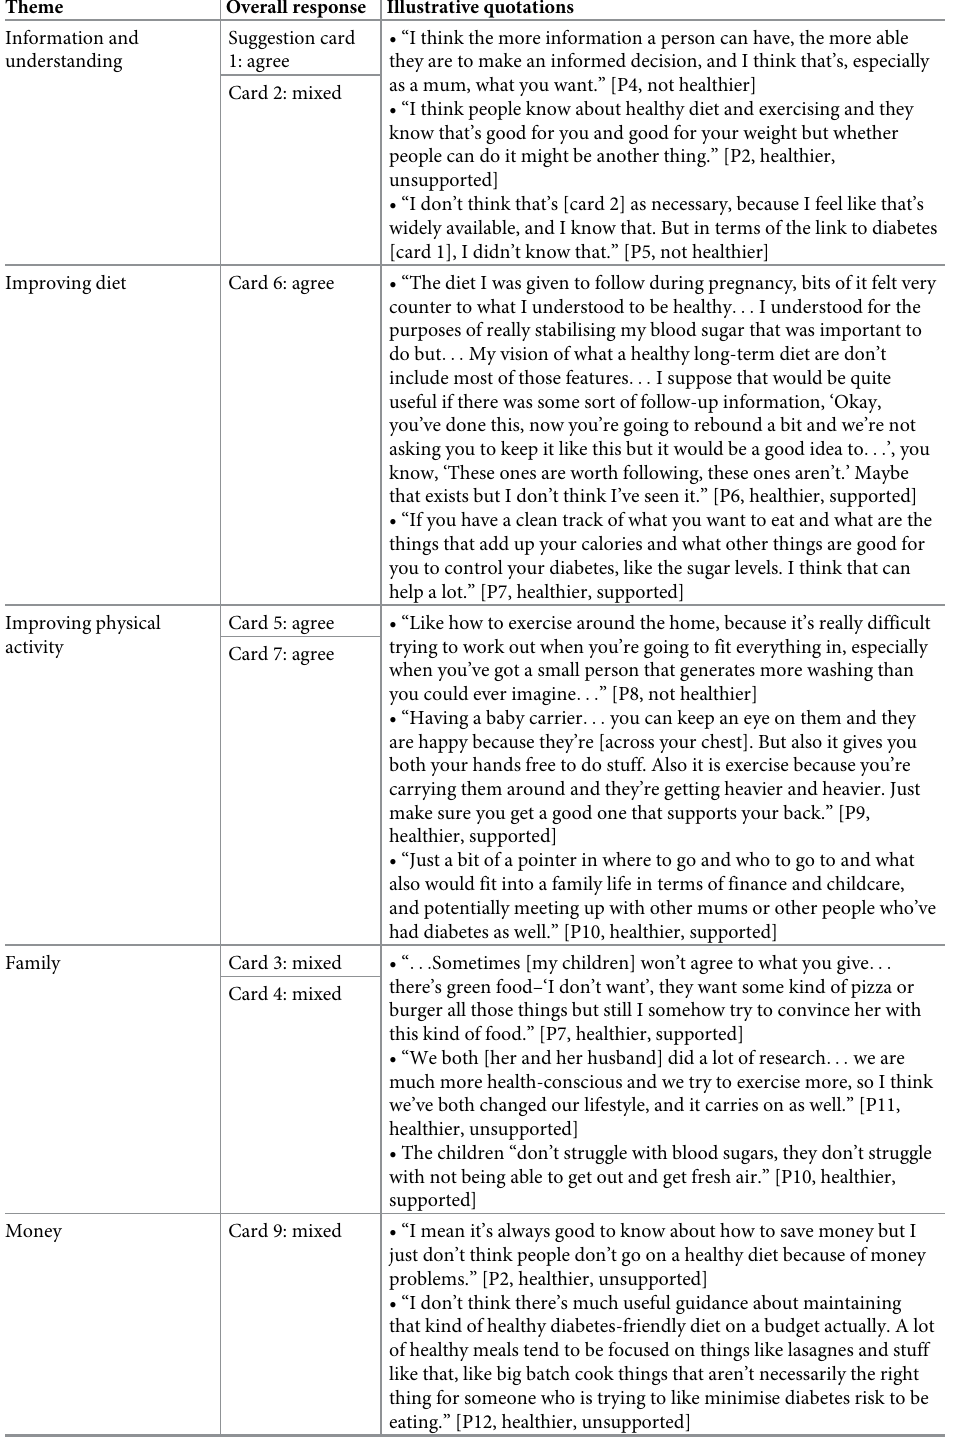
Table 2. Summary of the themes and participants’ agreement with whether the suggestion cards will support healthy diet and physical